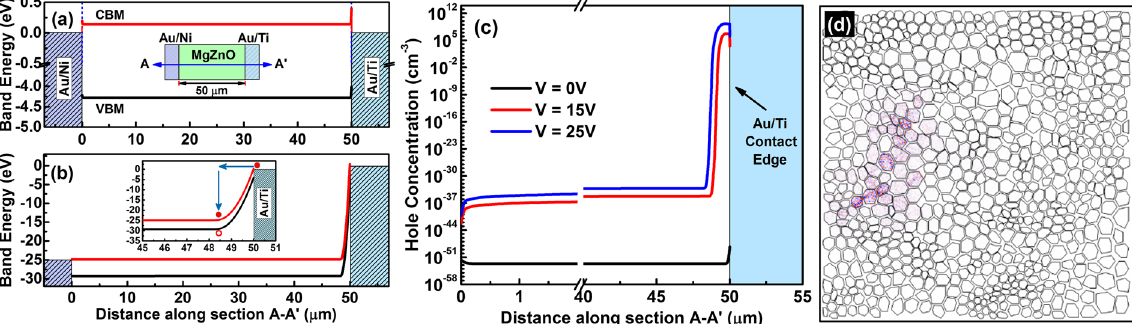
Figure 5. Simulation of hole generation and mode behavior in MgZnO MSM devices. Band diagram of MgZnO along A-A ′ section direction for ( a ) V = 0 V and ( b ) V = 25 V. CBM and VBM in ( a ) stands for conduction band minimum and valance band maximum, respectively. The inset in ( b ) shows the impact ionization process by hot electrons in the high field region, ( c ) Hole concentration along A-A ′ section from non- local impact ionization model, ( d ) The intensity of electric field distribution along c-axis corresponding to one possible lasing mode for Mg 0.45 Zn 0.55 O film (Sample